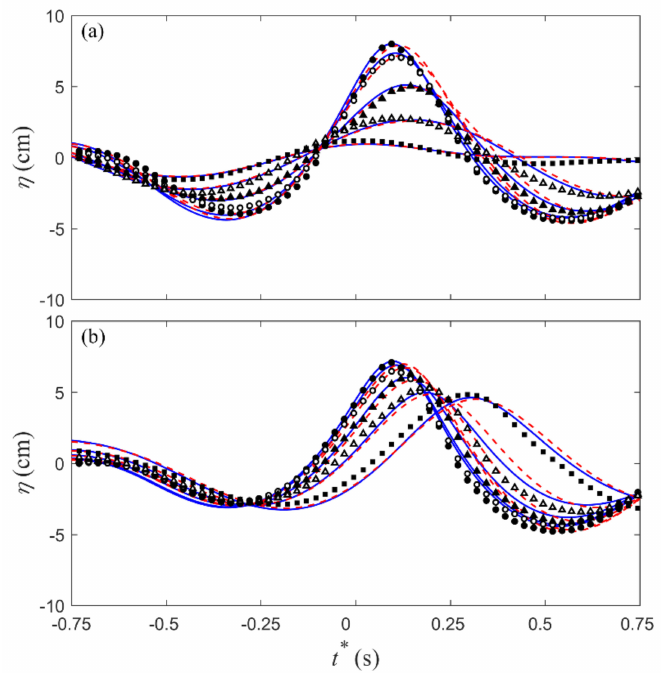
Figure 19. Comparison of the predicted free-surface displacement time series along lateral direction, that is, y = 0 m (filled circles), 0.3 m (open circles), 0.6 m (filled triangles), 0.9 m (open triangles), and 1.5 m (filled squares) for 3D spatially ( a ) focusing and ( b ) di ff racting waves: experimental data (symbols), FNHS mode (solid lines), and QNHS mode (dashed